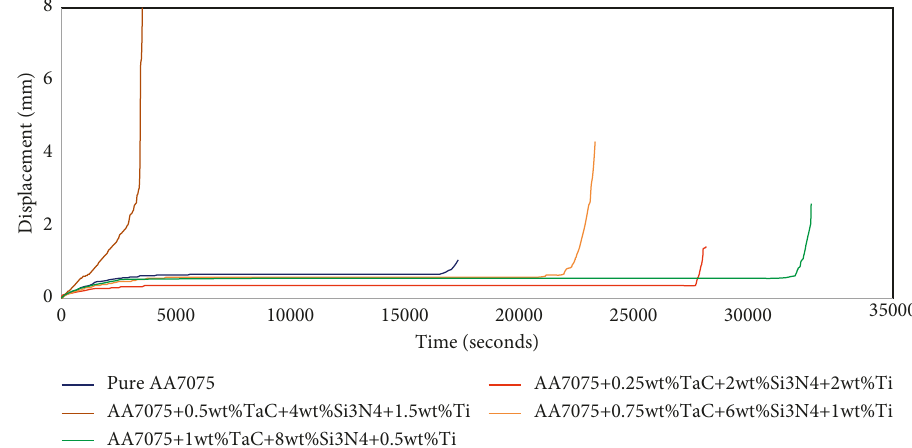
Figure 16: Variation of strain with respect to time of rupture of MMCs.